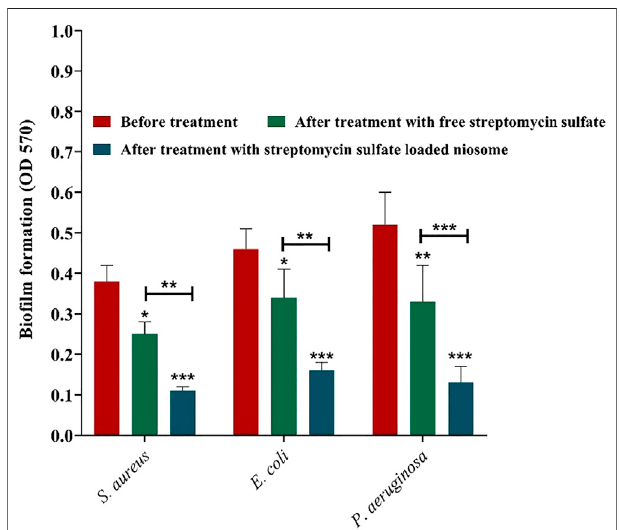
FIGURE 7 | Anti-bio fi lm activity of free and niosome-encapsulated streptomycin sulfate against selected pathogenic bacterial bio fi lms at their minimalinhibitionconcentrationsshownin Figure5 .Bio fi lmswereformedina 96-well microplate and, consequently, treated for 24 h at 37 ° C. The remaining bio fi lm was quanti fi ed by CV staining and compared with the untreated one. Data represent the mean ± SD ( n (cid:1) 3). Error bars represent standard deviations. The levels of signi fi cant difference are denoted by * p value < 0.05, ** p value < 0.01, and *** p value < 0.001.